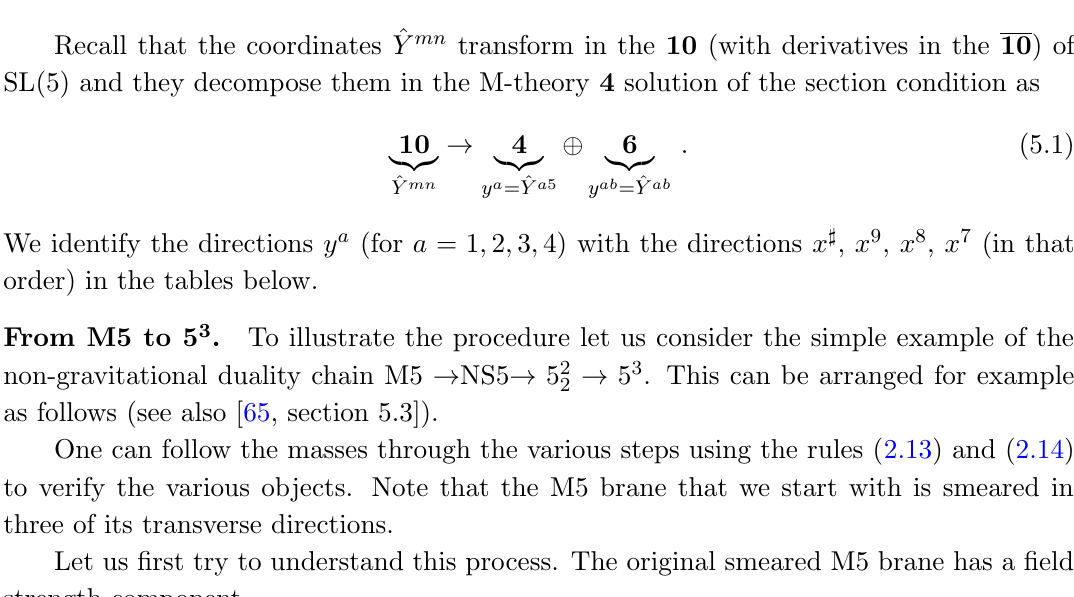
Table 6 . Traditional SL(5) U-duality orbit of a smeared M5 brane to a 5 3 -brane with corresponding potentials and E 11 roots. The (cid:15) indicates the two non-compact directions on which the smeared M5 brane depends while (cid:12) denotes directions that appear quadratically in the BPS mass formula. (cid:2) are world-volume